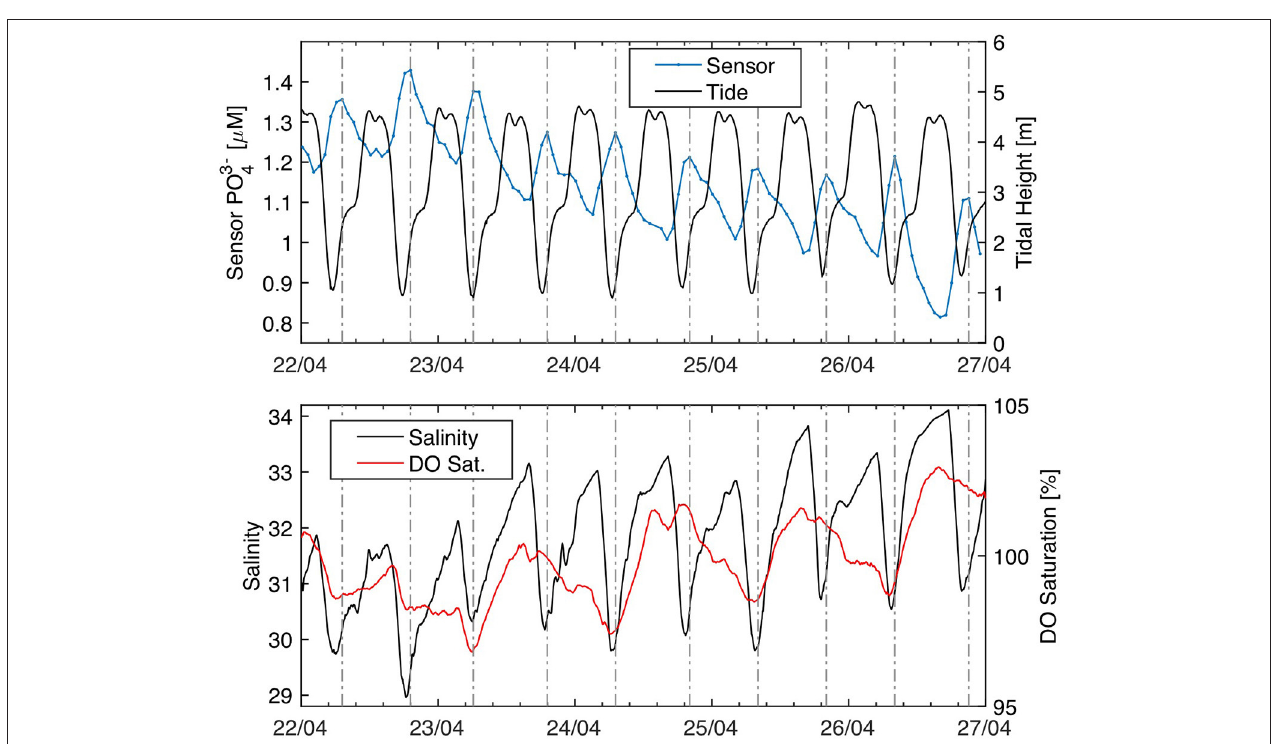
FIGURE 9 | Phosphate tidal cycling at the Empress Dock, Southampton Water. (A) Phosphate and tidal height. (B) YSI salinity and dissolved oxygen. The dashed vertical lines highlight the position of the phosphate maxima recorded by the sensor. A moving average was applied to the sensor (window size = 4) and YSI data (window size = 24). Tide data from SOTONMET (Associated British Ports).